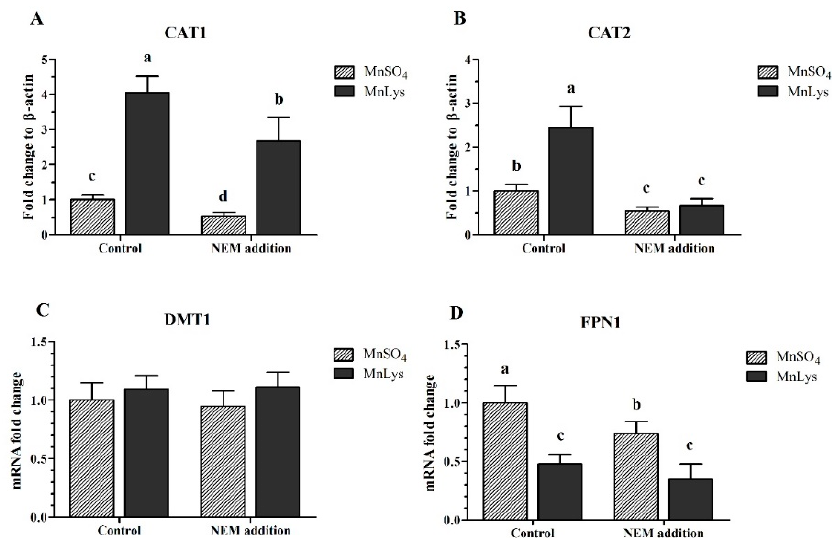
Figure 5. Influences of N -ethylmaleimide (NEM) and Mn source treatments on the membrane transporters genes expression in the primary chicken intestinal epithelial cells (IECs). The primary confluent IECs were pretreated with 5 μ M NEM for 10 min and then were incubated with 0.25 mM Mn from MnSO 4 or Mn-lysine complex (MnLys) for 60 min in the presence of NEM. The mRNA abundance of cationic amino acid transporter (CAT) 1, CAT2, divalent metal transporter 1 (DMT1), and ferroportin 1 (FPN1) was determined by real-time RT-PCR. Interaction of Mn source and NEM addition influenced CAT1, CAT2, and FPN1 transcriptional expression ( p < 0.05). Values are least- square means ± standard error ( n = 8). a-d Mean values lacking a common letter are different at p < 0.05.